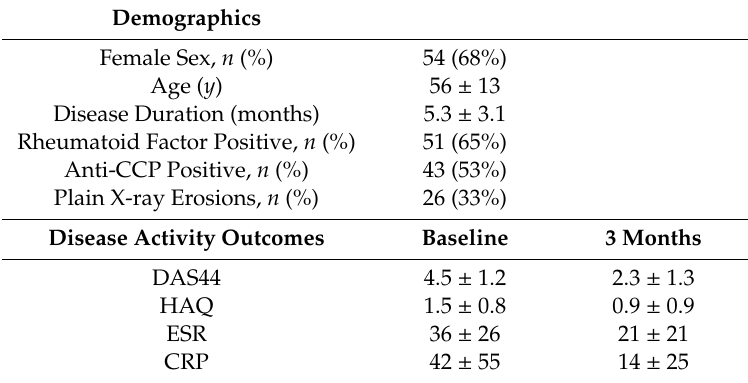
Table 1. Baseline characteristics and disease activity outcomes of metabolomics cohort ( n =